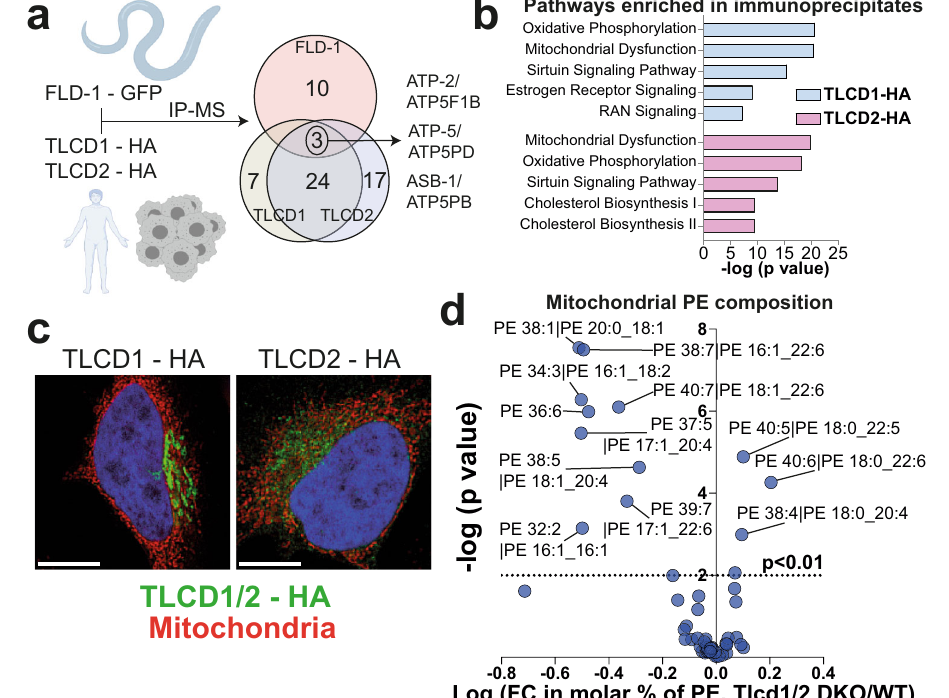
Fig. 3 | TLCD1/2 interact with mitochondria and regulate hepatocyte mito- chondrialPEcomposition.a DesignandsummaryofGFP-FLD-1andHA-TLCD1/ 2 IP experiments performed in C. elegans GFP-FLD-1 strains ( n =4 biological replicates) and in HepG2 cells with stable HA-TLCD1 or HA-TLCD2 expression ( n = 5 clones/condition). IP-MS: immunoprecipitation followed by mass spec- trometry. Overlapping hits (ATP synthase subunits) are indicated. b Ingenuity Pathway Analysis (using genome-wide proteome reference database) of the interacting proteins enriched in either HA-TLCD1 or HA-TLCD2 HepG2 IPs compared to negative controls. The list of protein hits for each pathway are provided in the Supplementary data 2. c Representative (from 2 independent